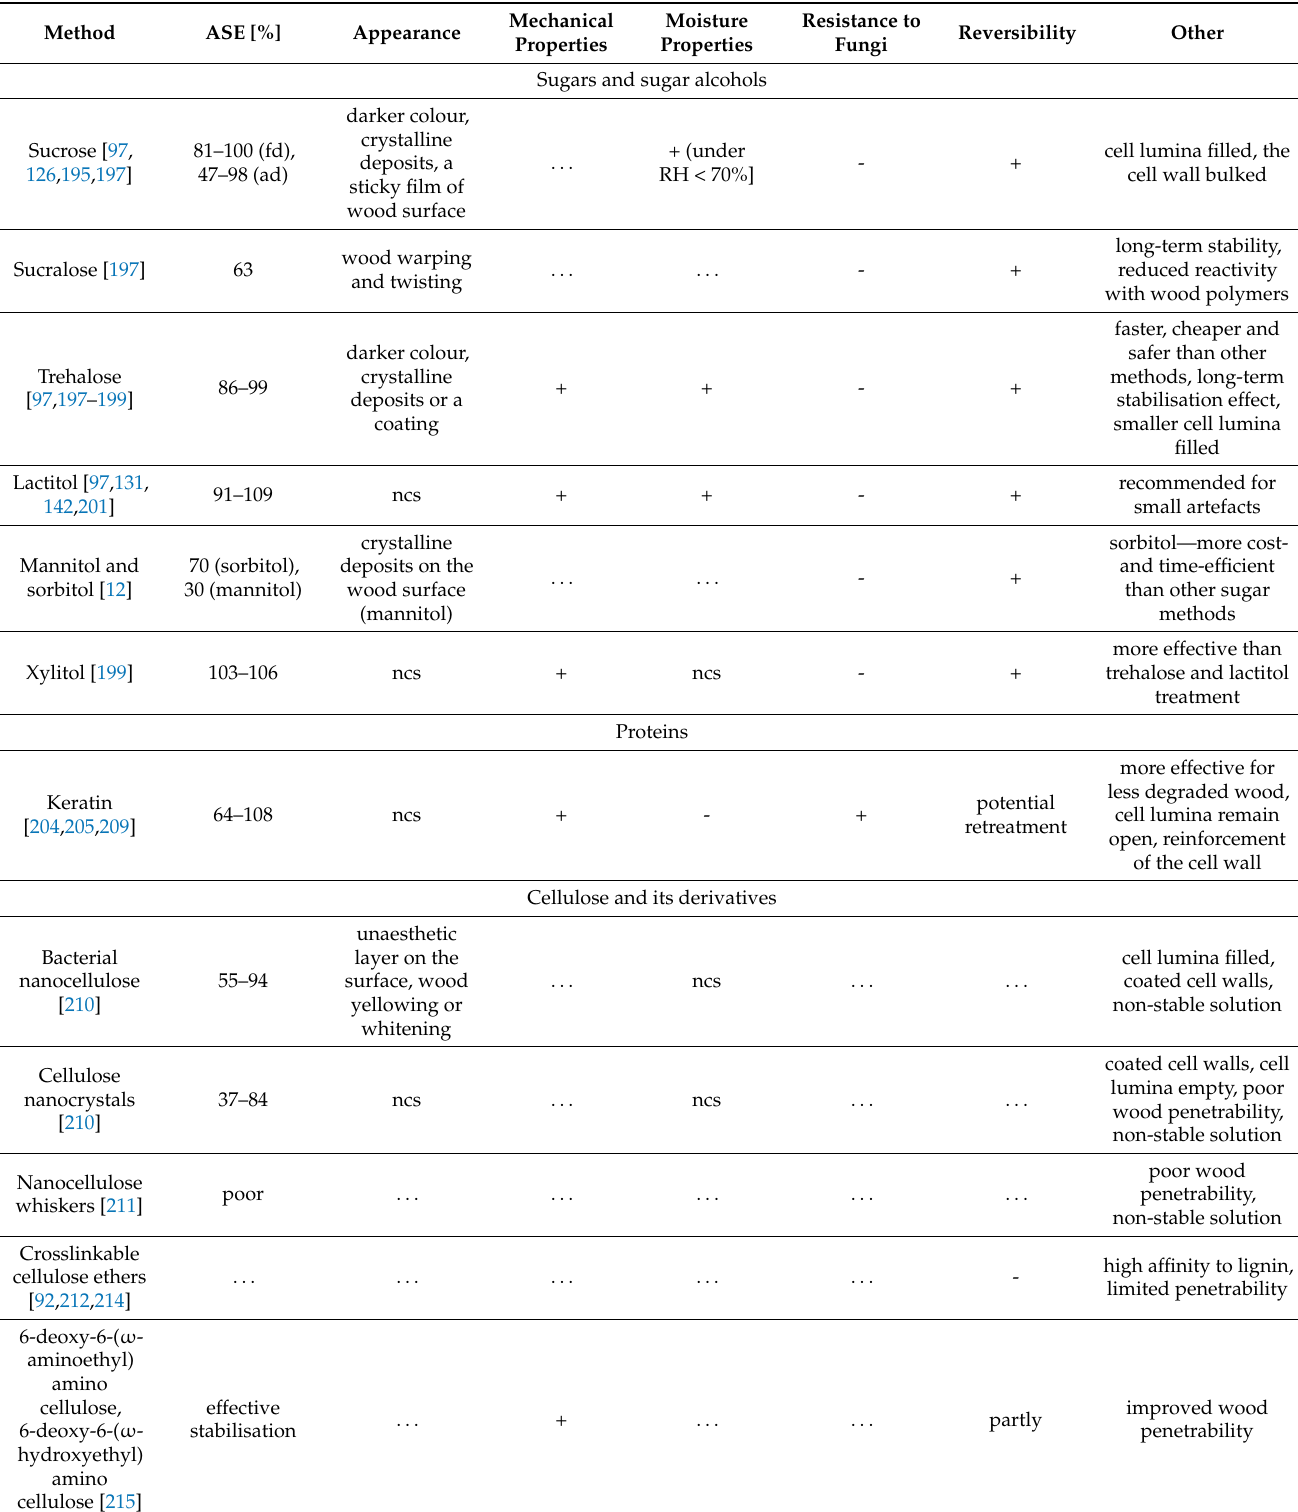
Table 2. The effects of different conservation methods on wood properties: “+”—improvement, “-”—negative effect, “ncs”—not changed significantly, “ . . . ”—not studied; “fd”—freeze-drying, “ad”—air-drying.